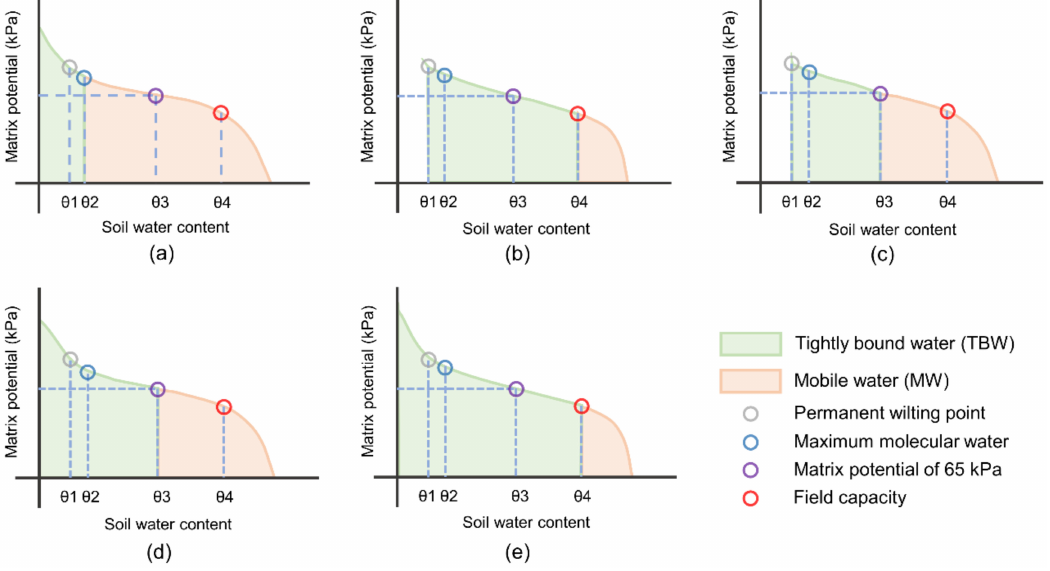
Figure 5. Classification of soil water types based on ( a ) soil physics and ( b – e ) ES hypothesis. θ 1– θ 4 represent the corresponding soil water content under di ff erent conditions. Figure 5 graphs